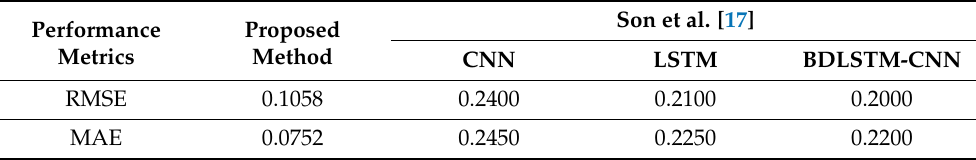
Figure 9. Comparison of results with other prediction model. 6. Conclusions This study proposed a method of using data augmentation and LSTM to predict fu ‐ ture maritime traffic conditions. Scenarios were established by combining various fea ‐ tures, and model training and evaluation were performed. The results confirmed that the performance of the model improved as more features were applied. The maximum values